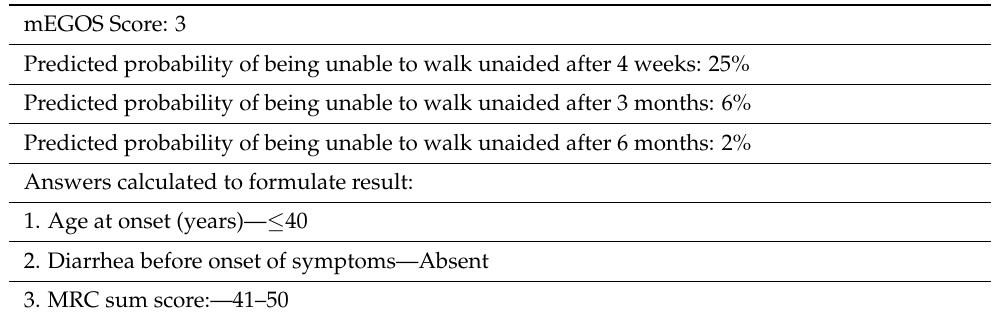
Table 2. Results for Modified Erasmus GBS Outcome Score (EGOS) at day 7 of admission. mEGOS Score: